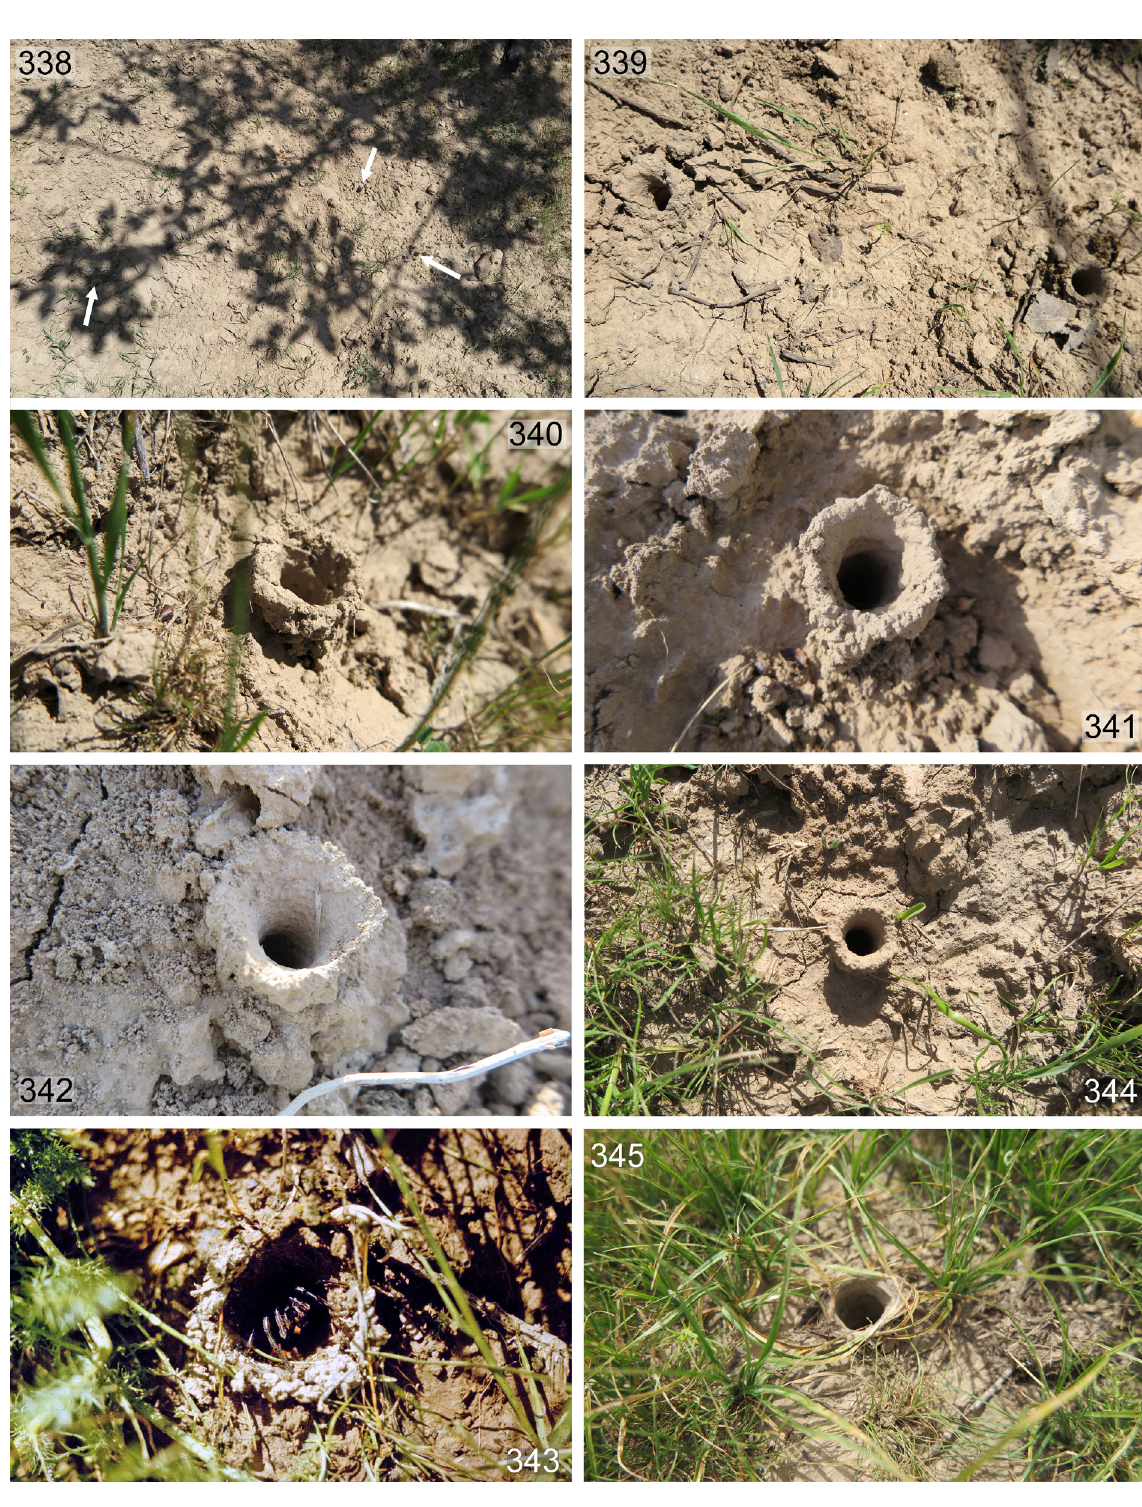
Figs 338–345. Anemesia spp., burrow entrances and their aggregations (338 –339); Tajikistan. 338– 343 . A. incana Zonstein, 2001 (Ganjina). 344 . Same (Mt Hojamaston). 345 . A. infumata sp. nov. (Panj Karatau Mts). White arrows indicate burrow